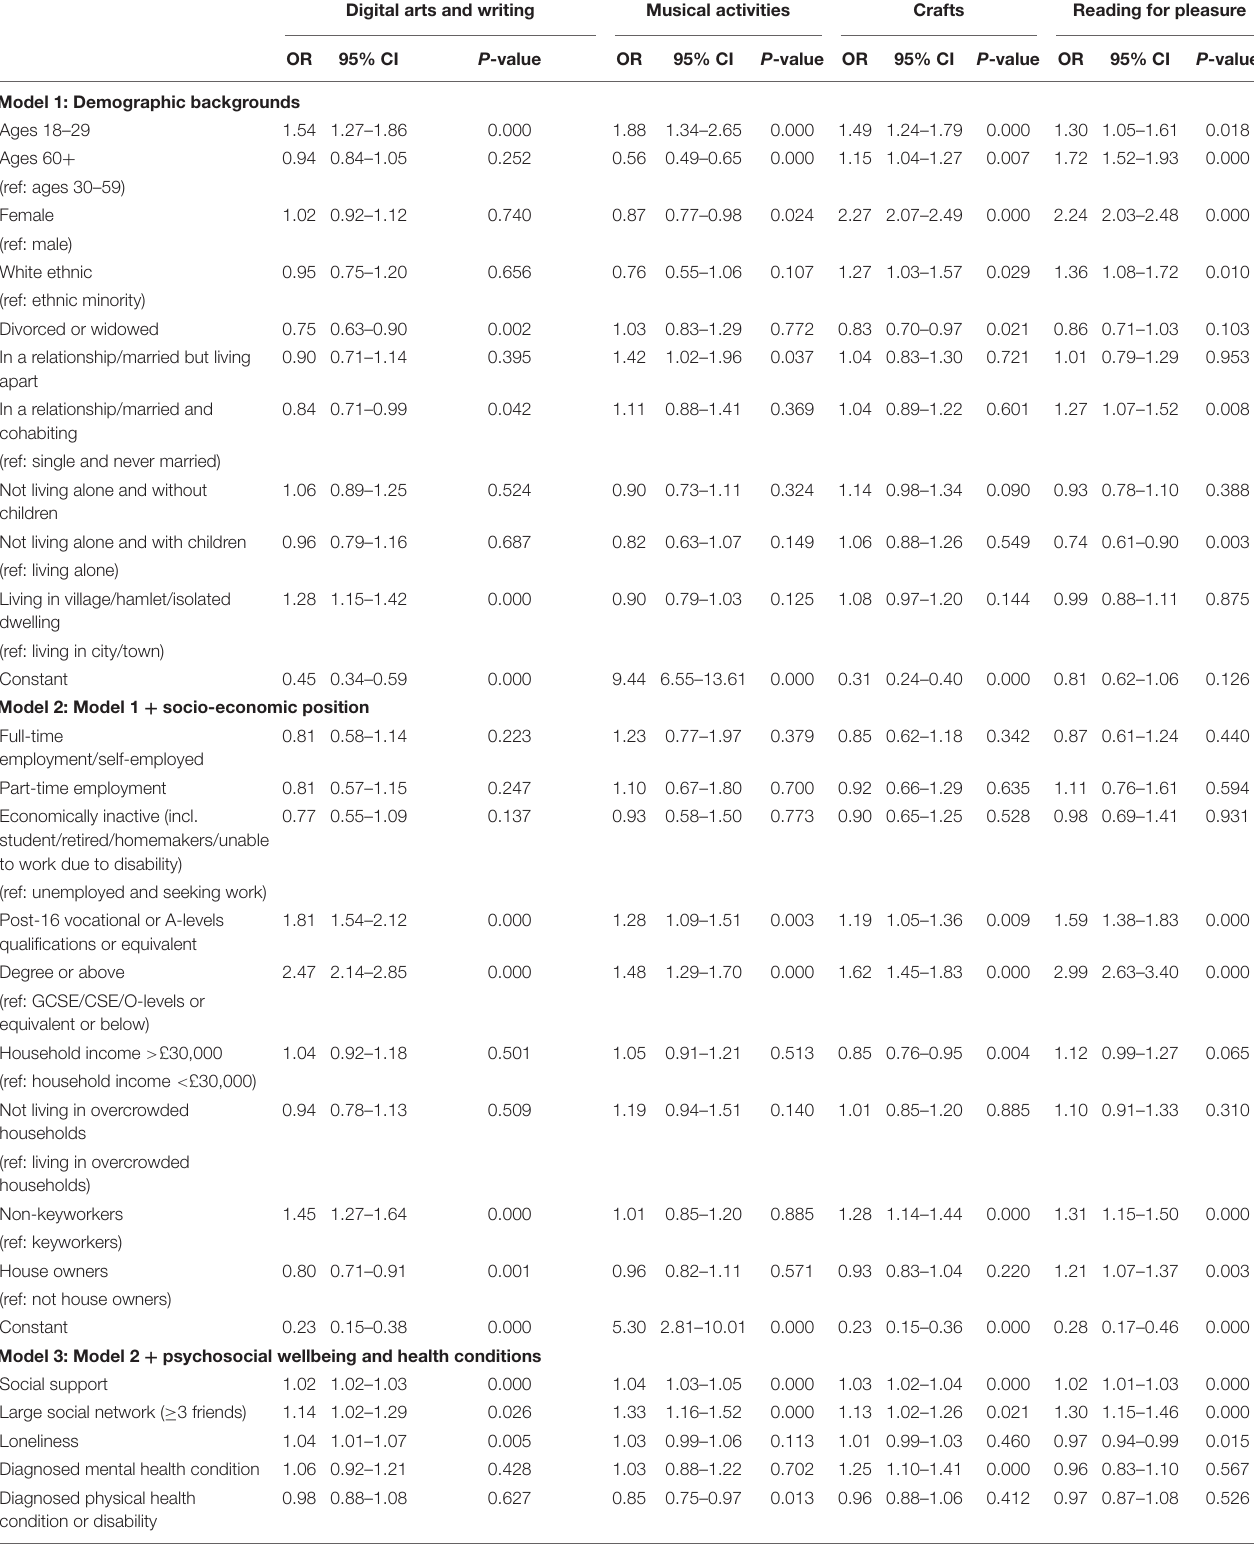
TABLE 3 | Logistic regression predicting the types of arts activities during the COVID-19 pandemic in the United Kingdom (weighted; N = 19,384). Digital arts and writing Musical